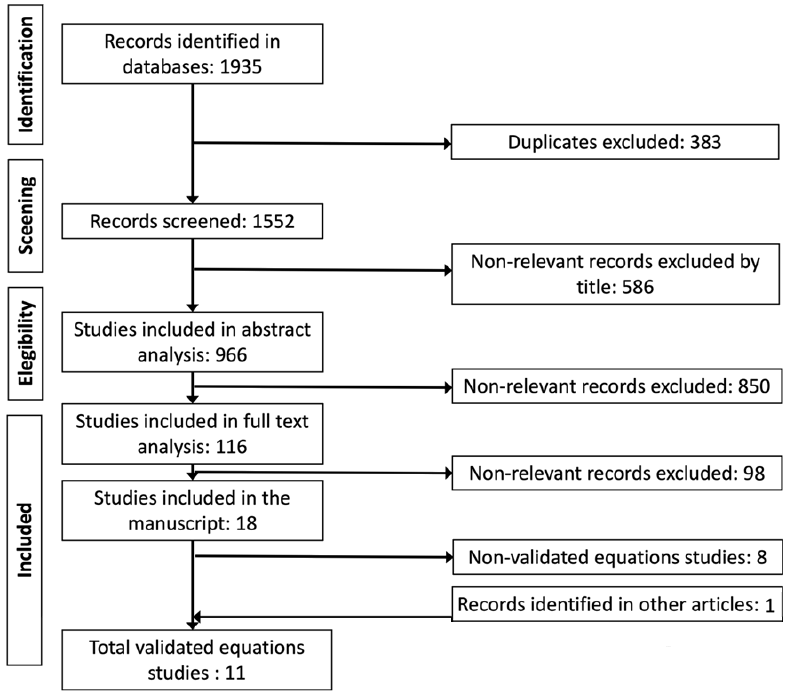
Figure 1. PRISMA 2020 method for the manuscript selection (Page et al., 2021 [20]).